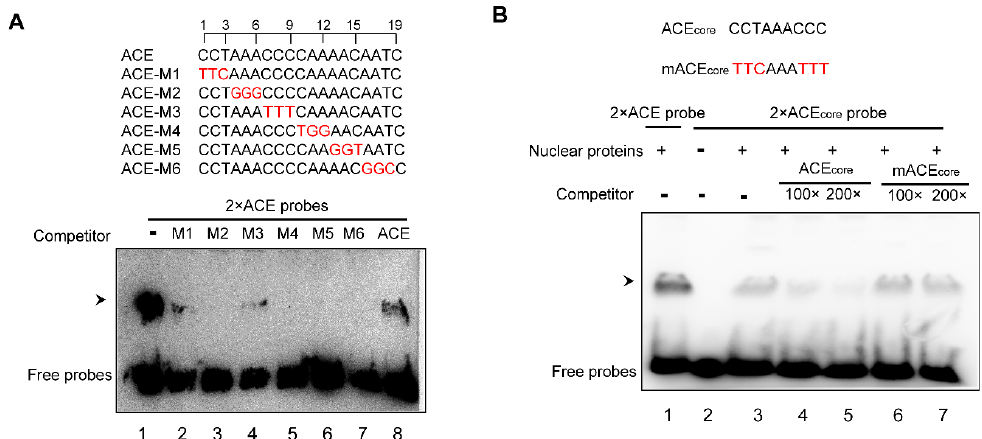
Figure 3. Competitive EMSA identifies the required sequences of ACE for nuclear protein binding. ( A ) ACE (2×) was used as the probe in the EMSA with the nuclear proteins, and the mutant variants (red cases) were used as competitors (50-fold molar). ( B ) Gel shifts with the ACE core probe (2×) showing ACE core are shown in red. A repeat experiment confirmed the results (Figure S1).